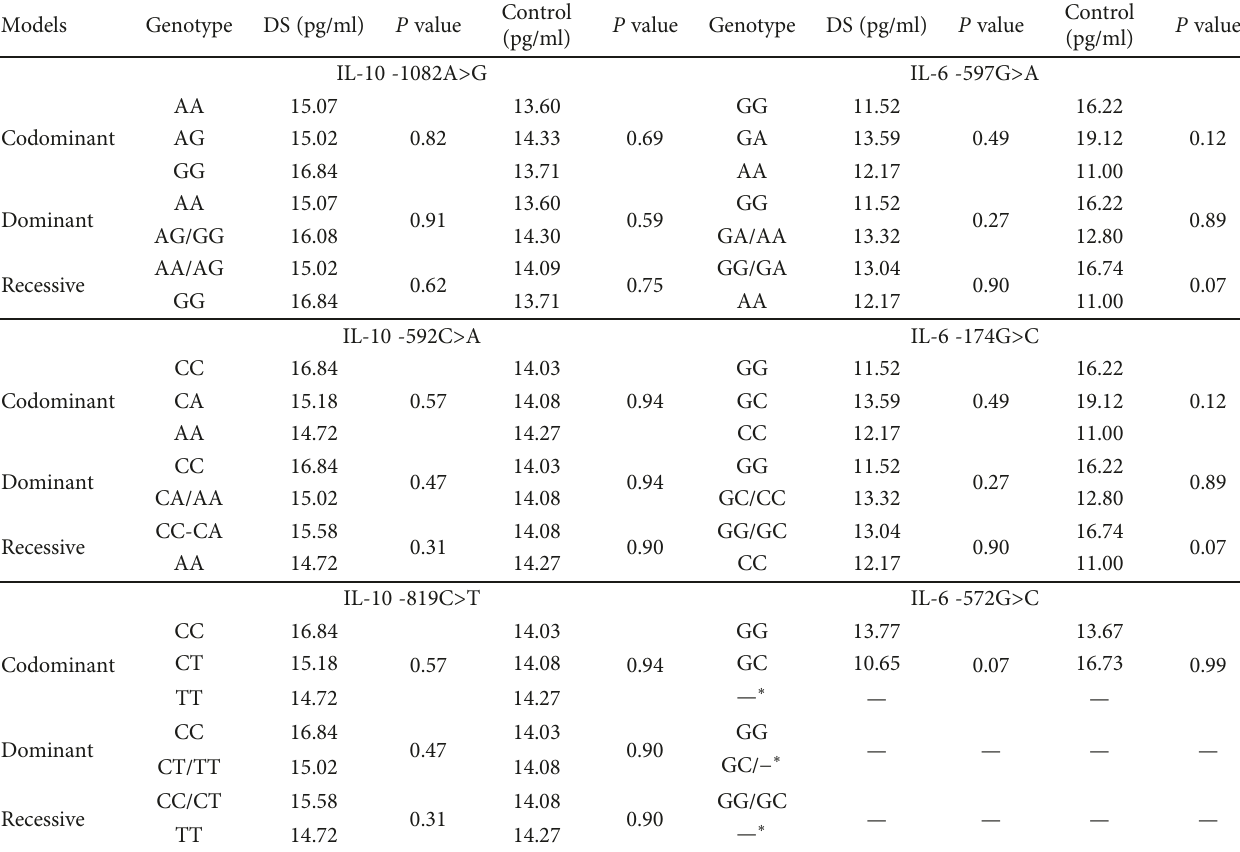
Table 2: IL-6 and IL-10 serum levels in relation to the